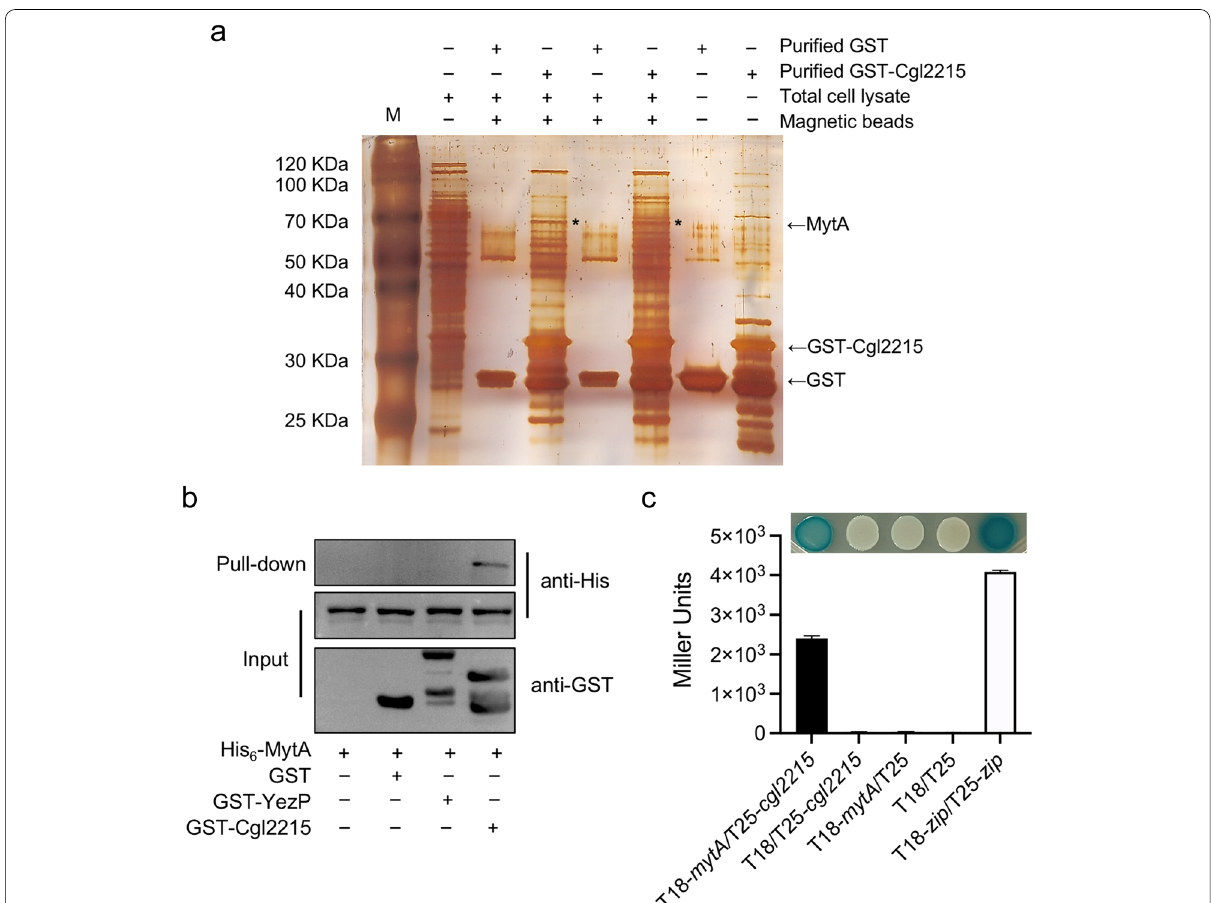
Fig. 3 Cgl2215 interacting with MytA. a Screening of Cgl2215-interacting proteins by GST pull-down coupled with mass spectrometry. The target proteins captured by magnetic beads were separated by SDS-PAGE and silver stained. C. glutamicum cell lysates (lane 1), the captured proteins by beads coated with GST (lanes 2 and 4) or GST-Cgl2215 (lanes 3 and 5), purified GST protein (lane 6), and GST-Cgl2215 protein (lane 7). b GST pull-down to verify the interaction between MytA and Cgl2215. The lysate supernatants of E. coli strains expressing His 6 -MytA only or expressing His 6 -MytA with either GST-Cgl2215 or GST were individually loaded onto the GST-bind resin, and the resin was then washed to remove nonspecific-bounded proteins. The initial lysate (input) and retained proteins (pull-down) were analyzed by western blot against GST or His antibody. GST was as a negative control and GST-YezP was as an unrelated control. c Bacterial two-hybrid results to verify the interaction between MytA and Cgl2215. The cgl2215 and mytA DNA fragments were cloned into bacterial two-hybrid system for colony color and enzymatic activity assay. T18- mytA /T25- cgl2215 : E. coli BTH101 containing pKT18cm- mytA and pKT25m- cgl2215 ; T18/T25- cgl2215 : E. coli BTH101 containing pKT18cm and pKT25m- cgl2215 ; T18- mytA /T25: E. coli BTH101 containing pKT18cm- mytA and pKT25m; T18/T25: E. coli BTH101 containing pKT18cm and pKT25m; T18- zip /T25- zip : E. coli BTH101 containing pKT25m- zip and pKT18cm-